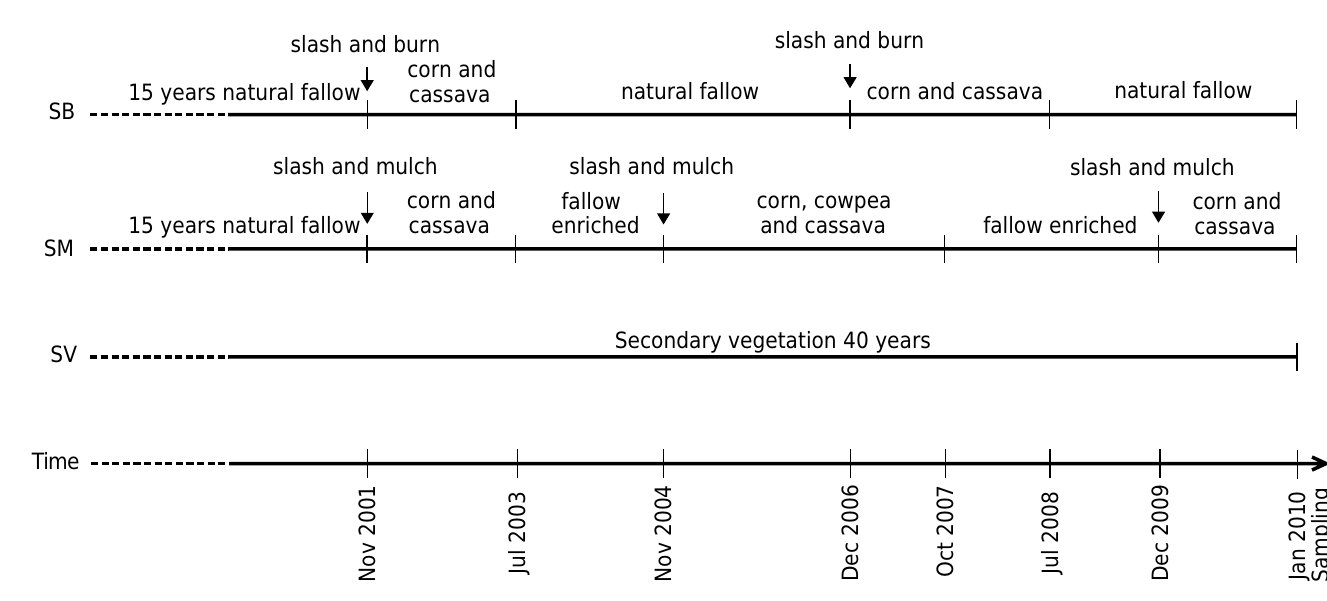
Figure 1. Plot history. Slash-and-burn (SB), slash-and-mulch (SM) and secondary vegetation (SV) systems at different depths in an Argissolo Amarelo Distrófico